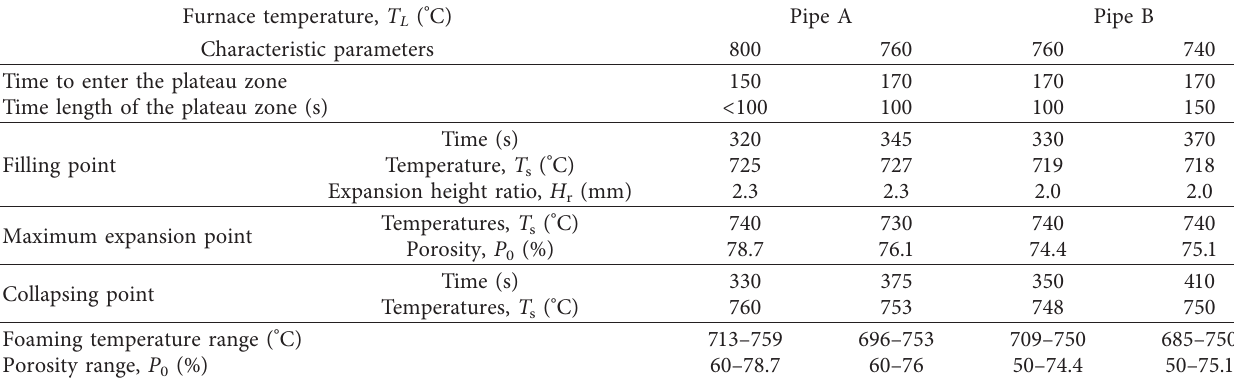
Figure 8: Relationship between the temperature and expansion height ratio of the sample in pipe A (a) and pipe B (b) at different furnace Table 2: Heating, foaming, and expansion parameters of samples at different furnace temperatures.